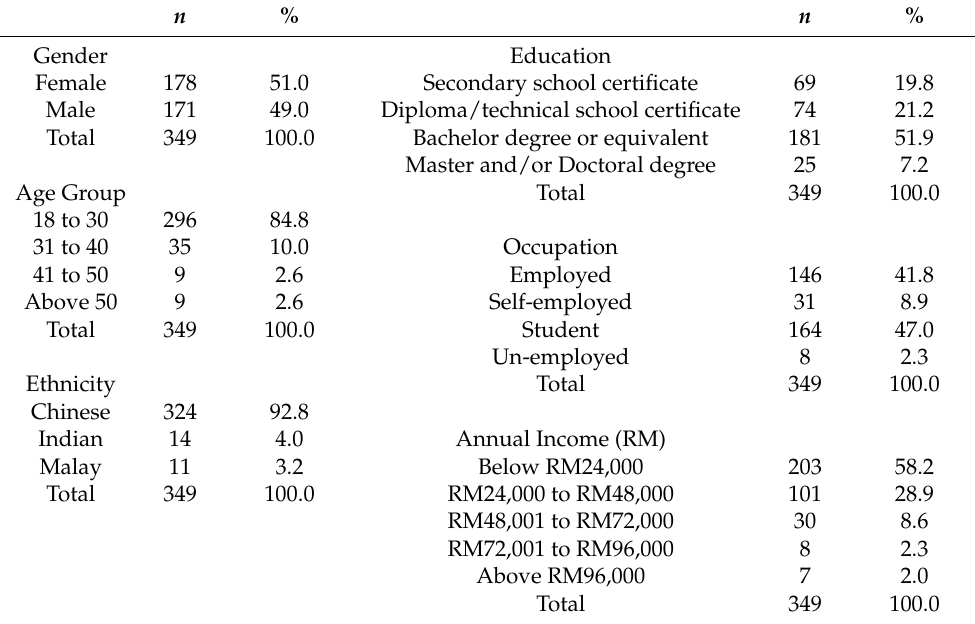
Table 1. Demographic